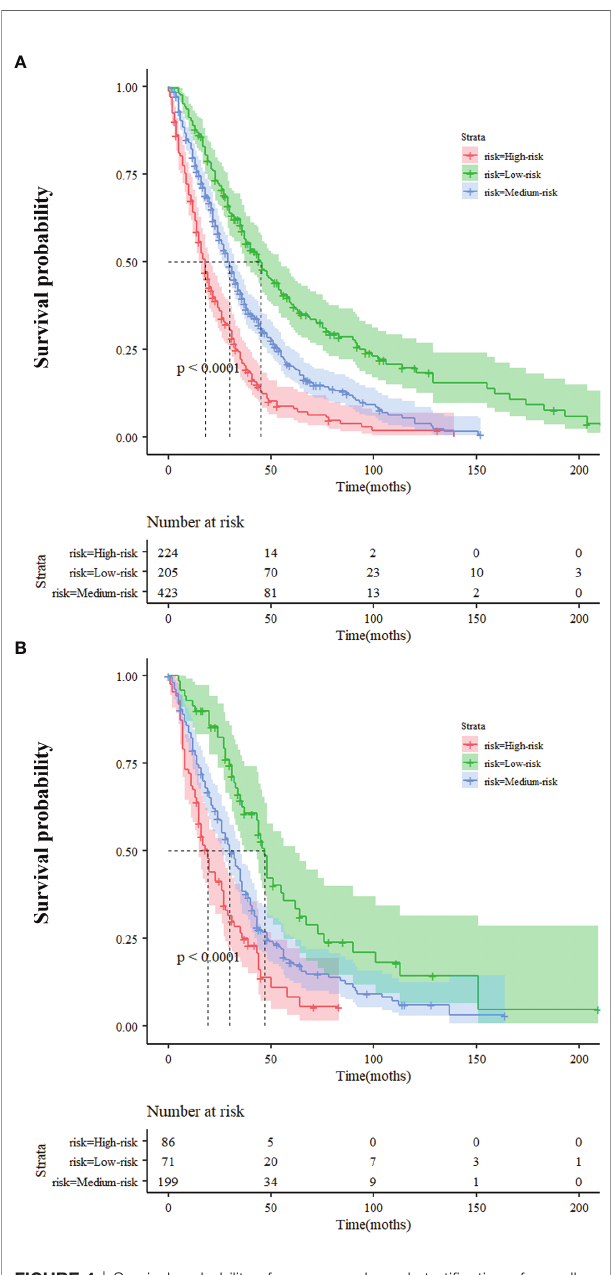
FIGURE 4 | Survival probability of nomogram-based strati fi cation of overall population (A) Training Cohort (B) Validation